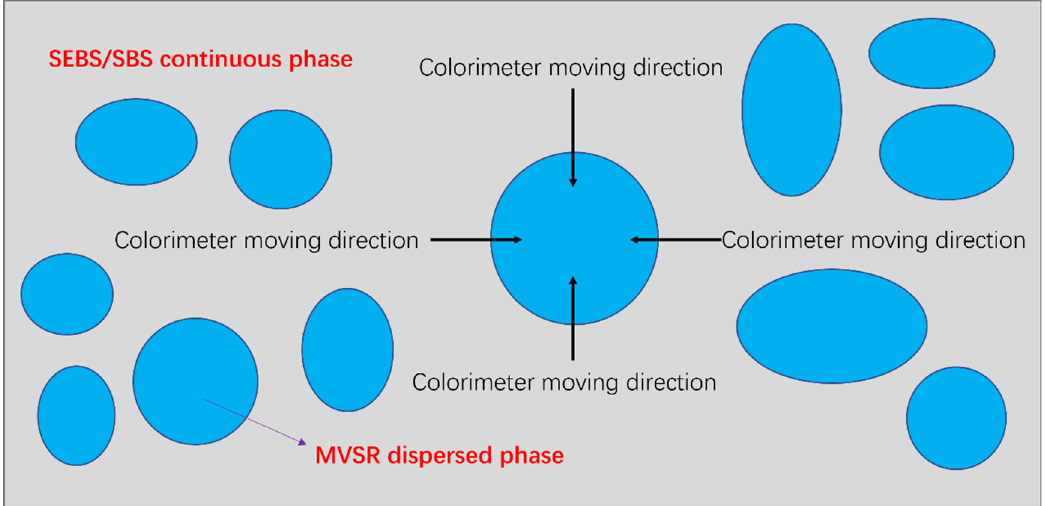
Figure 2. The test method for the colorimeter to test the size of the compatibility layer in TPV.